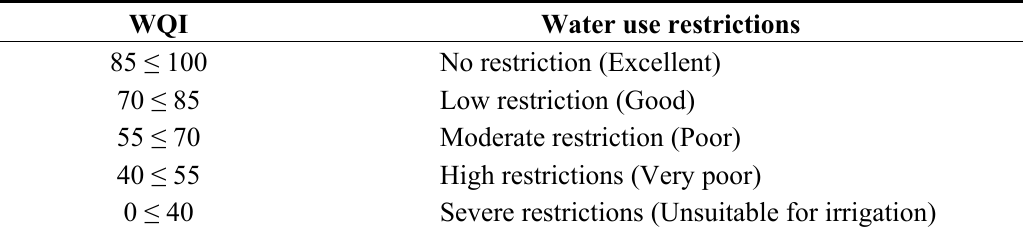
Table 2. Water quality index